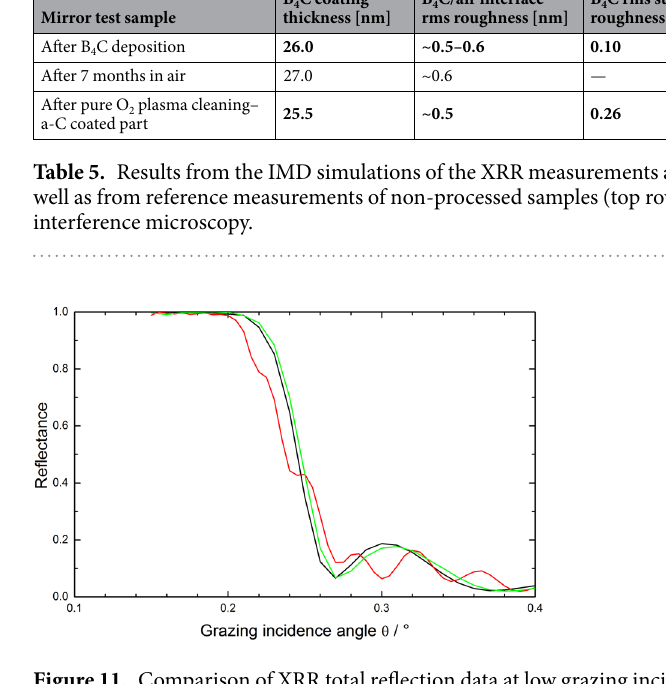
Figure 11. Comparison of XRR total reflection data at low grazing incidence angles for a pristine B 4 C-coated test mirror (black line), after a-C coating (red line), and after subsequent cleaning with pure O 2 plasma (green